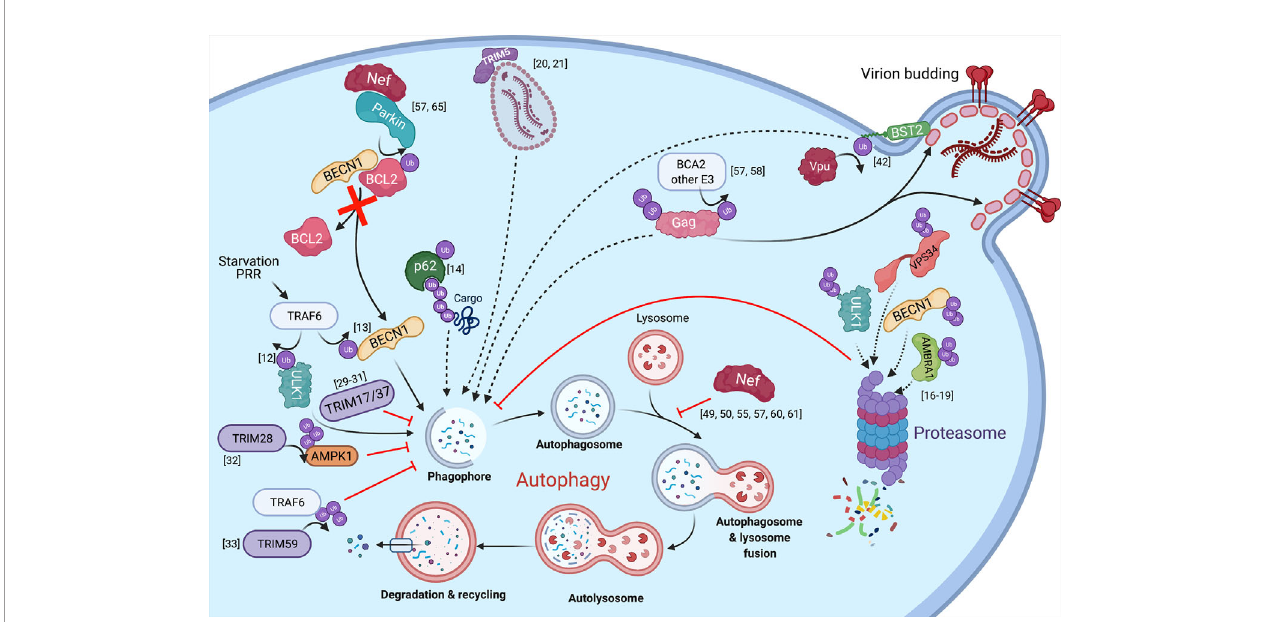
FIGURE 1 | The intersections between HIV infection and autophagy mediated by ubiquitination. The autophagy pathway and known interactions with HIV proteins are shown with regards to ubiquitination. Solid arrows represent the transfer of a ubiquitin group, direct contribution to the autophagy pathway, or show the steps of the autophagy cycle. Dotted lines represent substrates targeted for elimination. Red lines or arrows represent autophagy inhibition at corresponding steps in the